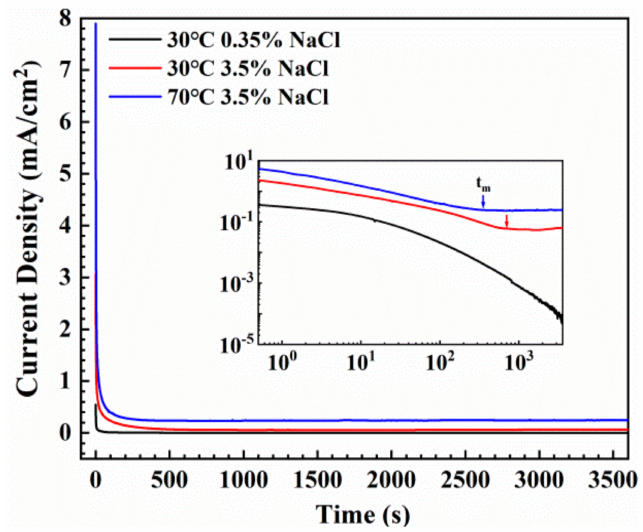
Figure 3. Current–time curve and log i -log t charts for Fe-based AMCs at various solution concentra- tion and temperatures at potential of 0 V SCE .